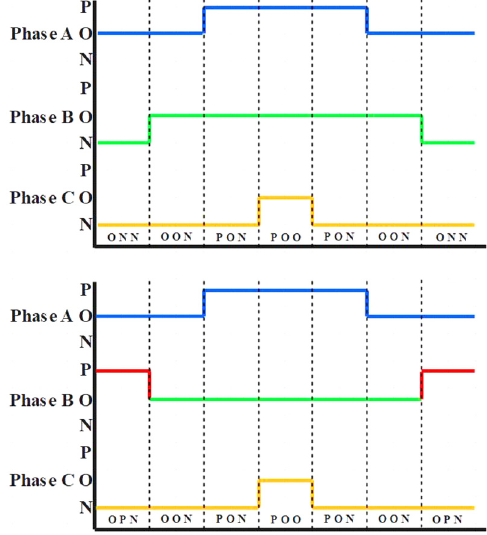
Figure 5. Ideal and actual voltage vector comparison.